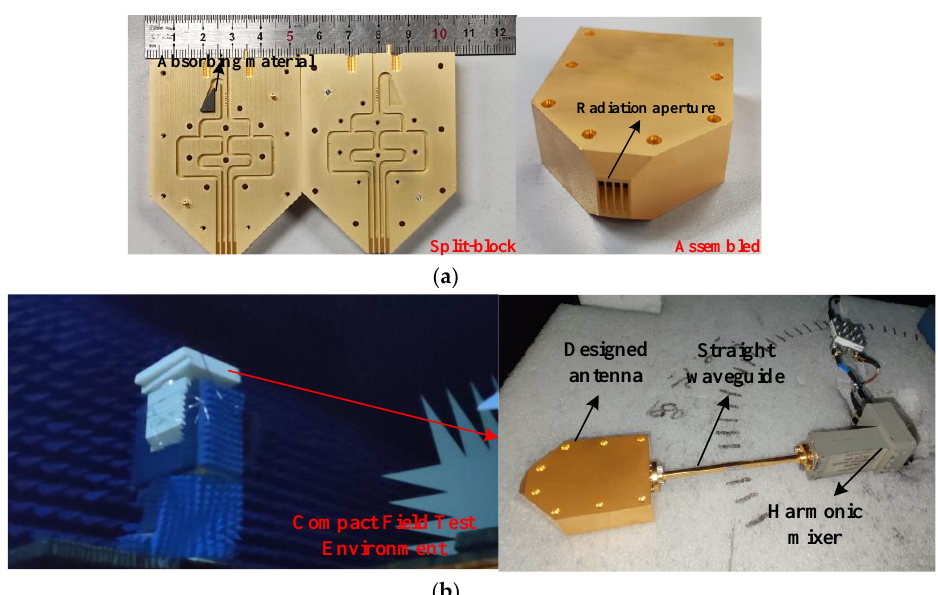
Figure 9. The photograph of ( a ) antenna fabricated by E-plane split block CNC-machining; ( b ) compact field measure environment.